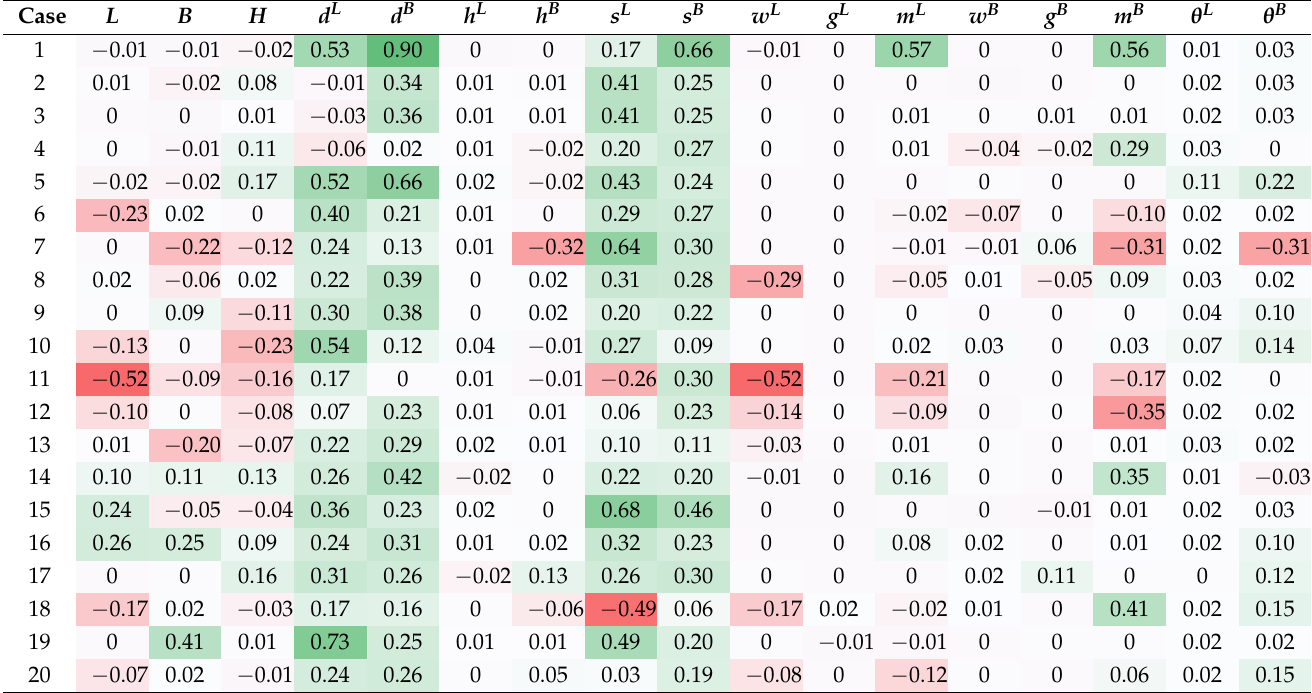
Table 4. Sensitivities calculated for EB-965 cardboard with min/max values marked in red and green, respectively, for all considered parameters (the darker color the more important parameter).